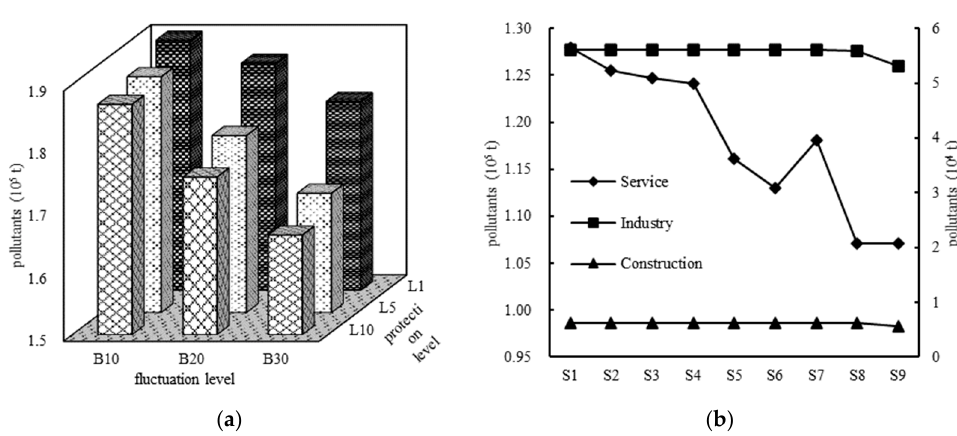
Figure 11. The overall COD pollutant load industry, construction and service in Bayan Nur City under nine scenarios. ( a ) Overall industry, construction and service. ( b ) Each